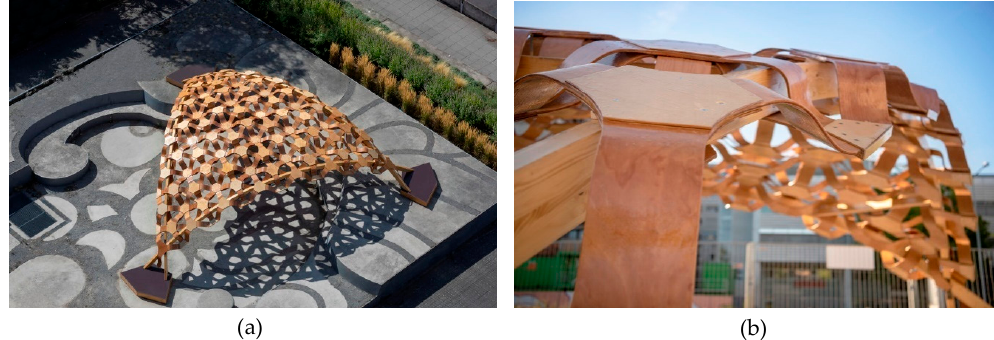
Figure 2. ( a ) The erected BioMat pavilion at the campus of University of Stuttgart; ( b ) Connections of modular biocomposite sandwich panels in combination with the structural beams. © BioMat/ ITKE-University of Stuttgart.